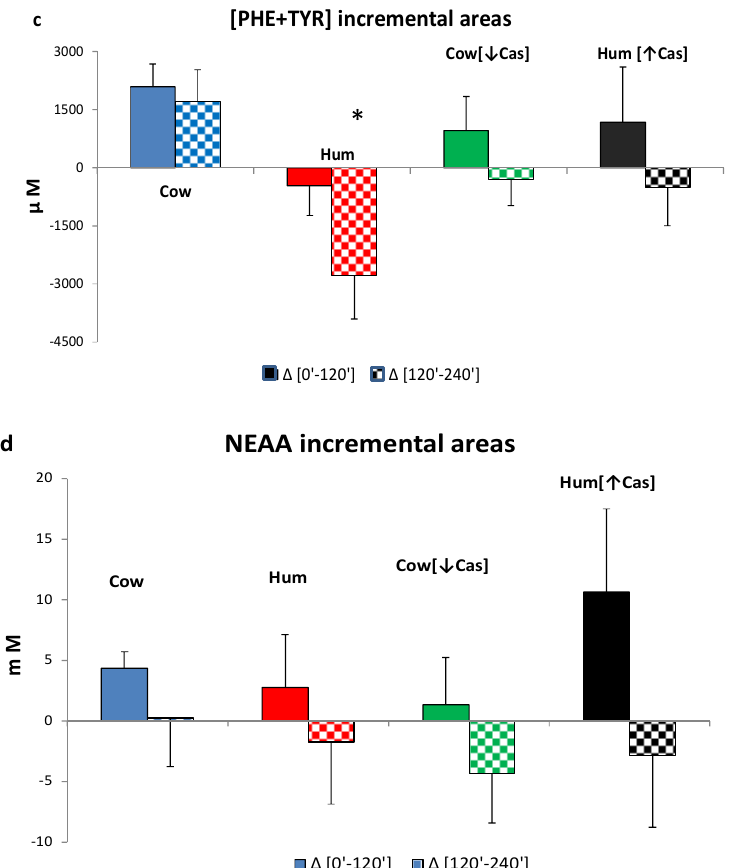
Figure 6. Incremental areas of amino acids. Abbreviations: AA: amino acids; BCAA: branchedchain AA; Phe: phenylalanine; Tyr: tyrosine; Hum: human; Cow [ ↓ Cas]: low-casein cow milk; Hum [ ↑ Cas]: high-casein human milk. ( a ): Integrated incremental areas under the curve (iAUC) over baseline, of total AA concentrations, in the [0′–120′] (left full bars) and the [120′–240′] iAUC (right checkered bars) time intervals, respectively. There was no difference, among the four milk types, in either the [0′–120′] or the [120′–240′] iAUC. The [120′–240′] areas were lower ( p < 0.0001) than the [0′–120′] ones (by the paired t test) in all milk groups. ( b ): Integrated incremental areas under the curve (iAUC) over baseline, of the BCAA concentrations, in the [0′–120′] (left full bars) and the [120′–240′] iAUC (right checkered bars) time intervals, respectively. The symbol (*) indicates a significant difference (by one-way ANOVA and the Fisher’s LSD test) between Cow and Hum milk ( p < 0.03) in the [120′–240′] iAUC. The symbol (§) indicates a significant difference ( p < 0.03) between Hum and Hum[ ↑ Cas] in the [0′–120′] iAUC. The symbol (#) indicates a significant difference ( p < 0.02) Cow [ ↓ Cas] and Hum[ ↑ Cas] in the [0′–120′] iAUC. The symbol (§§) indicates a significant difference ( p < 0.04) between Hum and Hum[ ↑ Cas] milk the [120′–240′] iAUC. The [120′–240′] areas were significantly lower ( p < 0.0001) than the [0′–120′] ones (by paired t test). ( c ): Integrated incremental areas over baseline, of the sum of phenylalanine (Phe) and tyrosine (Tyr) concentrations, in the [0′–120′] (left bars, full colors) and the [120′–240′] (right bars, checkered-pattern colors) time intervals, respectively. The symbol (*) indicates a significant difference between Hum and Cow milk in the [120′–240′] ( p < 0.003), as well as borderline-significant difference between the Hum and the Cow[-Cas] milk ( p = 0.057). The [120′–240′] areas were significantly lower [ p < 0.0001] than the [0′–120′] ones (by paired t test). ( d ): Integrated incremental areas over baseline, of the sum of non-essential amino acids (NEAA) (alanine, glycine, proline, serine, hydroxyproline, cysteine, glutamate, tyrosine), in the [0′–120′] (left bars, full colors) and the [120′–240′] (right bars, checkered-pattern colors) time intervals, respectively. There were no differences in the iAUC in any study group. The [120′–240′] areas were lower ( p = 0.001) than [0′–120′] ones (by the paired t test) in each experimental group except for the Cow milk group.